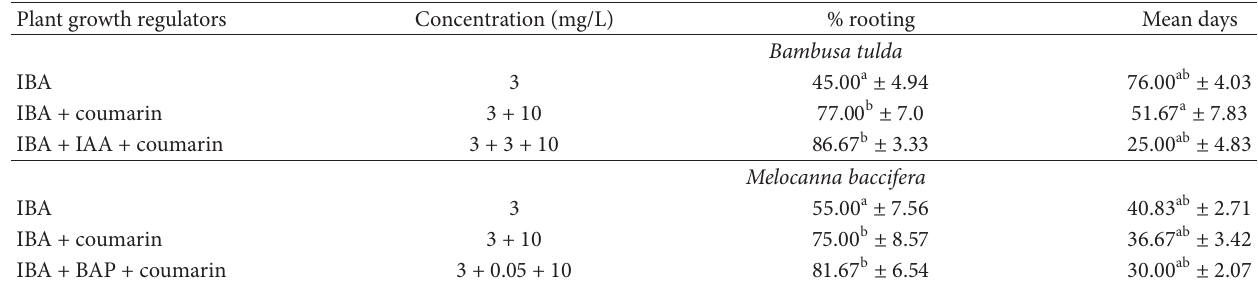
Mean of 10 replicates ± S.E., scored after 4 weeks in culture medium. Within each column, values followed by the same letter are not significantly different according to Tukey’s test at 𝑃 < 0.05 .